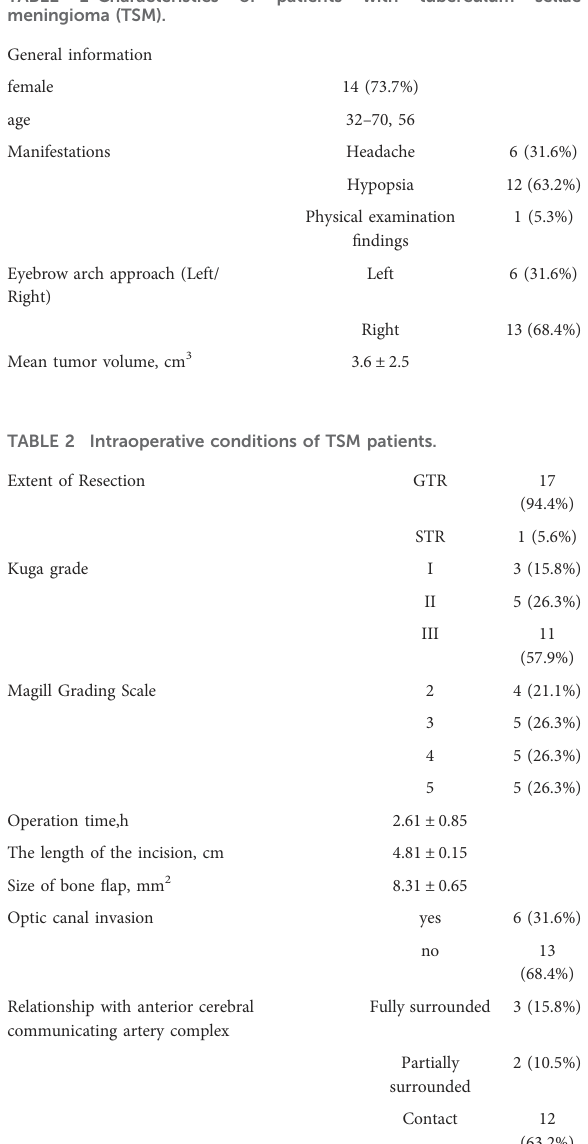
TABLE 1 Characteristics of patients with tuberculum sellae meningioma (TSM).